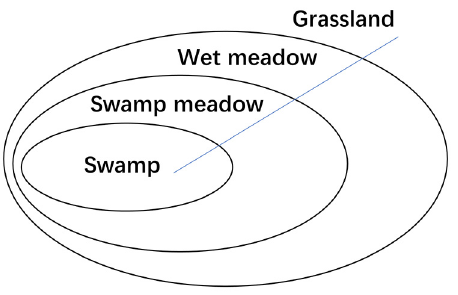
Figure 3. Swamp–swamp meadow–wet meadow spatial successional gradient distribution pattern in the ideal